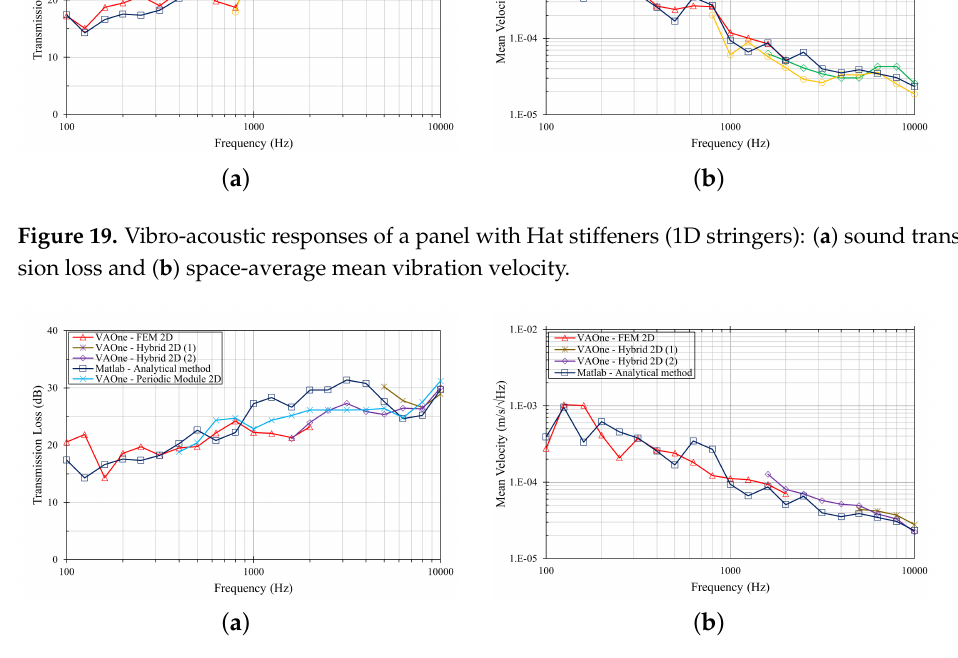
Figure 20. Vibro-acoustic responses of a panel with Hat stiffeners (2D stringers): ( a ) sound transmis- sion loss and ( b ) space-average mean vibration